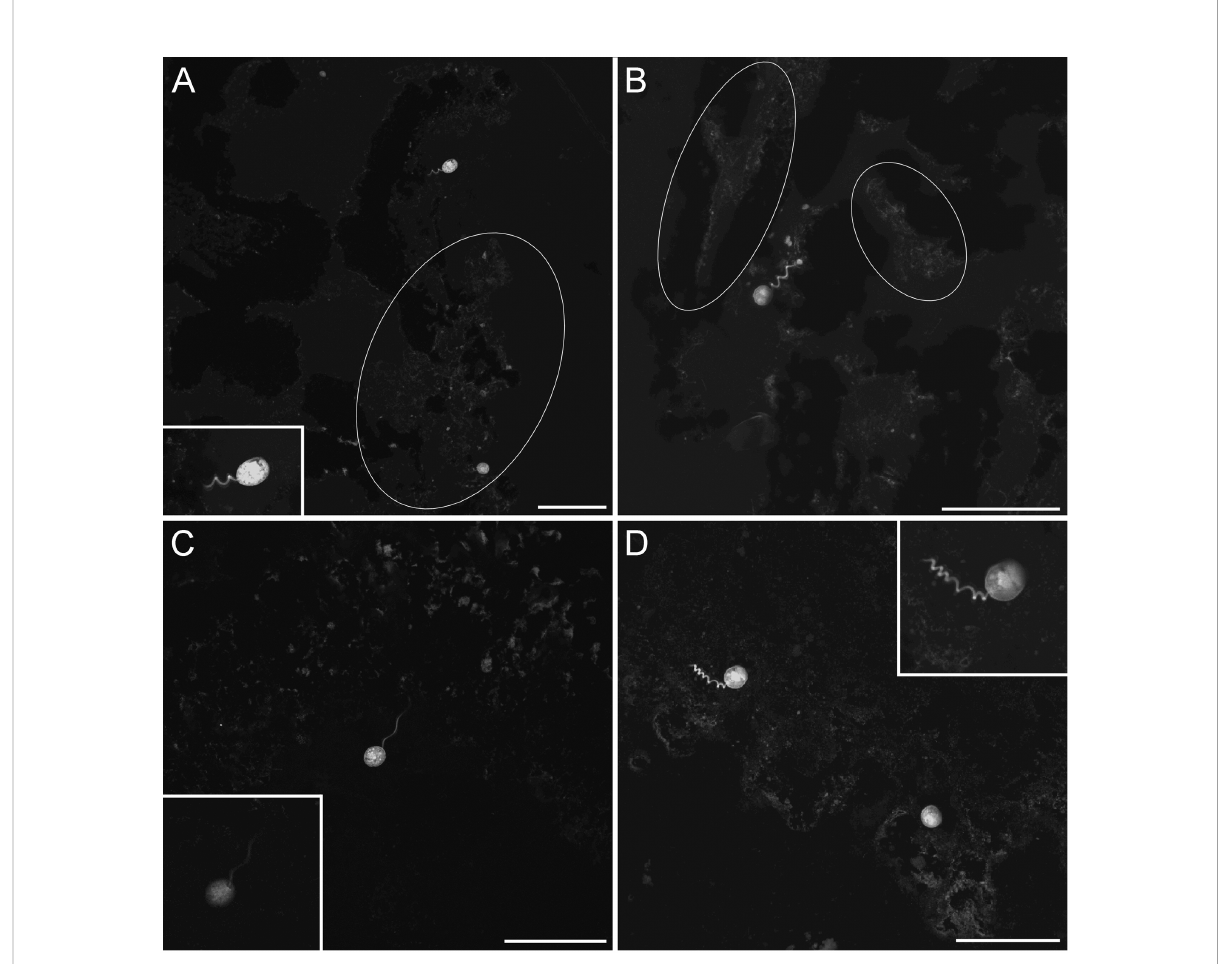
FIGURE 8 LSCM images (z-stacks) of the Vorticellid-like protist, all from chimney base sediments; all specimens in partial retraction. (A) Two individuals, occurring at the edge of Core 17, ~1 mm deep. Inset shows higher magni fi cation view of upper specimen. (B) Specimen near Core 17 edge, ~0.5 mm depth; white ovals in (A, B) highlight well-developed microbe aggregations. (C) Core 17, 1 mm deep. Inset reveals attachment between spherical body and stalk. (D) One stalked specimen and putative second specimen (lower right) from Core 19, ~0.5 mm depth. Inset shows close up of stalked specimen. Note all Vorticellid-like specimens extend into pore space, not into overlying bottom waters. White ovals highlight areas with well-developed bio fi lm. Number of images compiled/distance between images (µm): (A) = 29/0.7; (B) = 49/0.5; (C) = 9/0.5; D= 23/ 0.5; (A) Inset=48/0.3; (C) Inset=1 slice; (D) Inset=37/0.4. Scales: (A – D) = 100